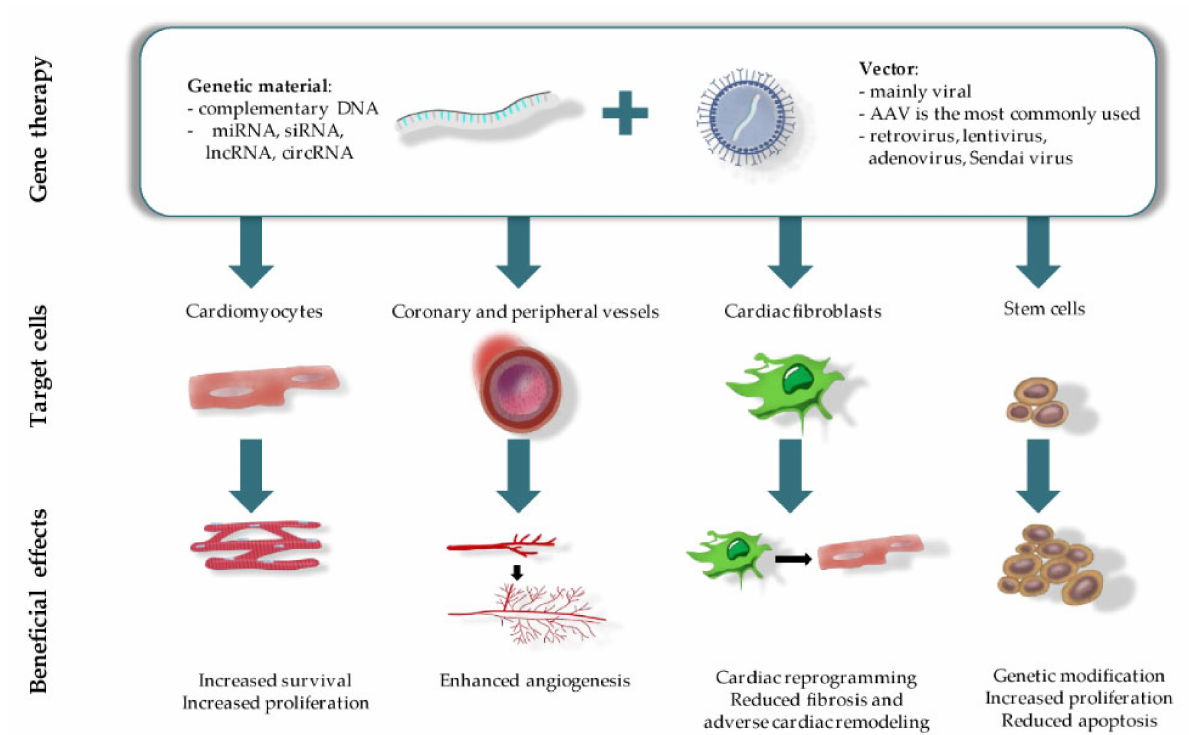
Figure 1. Gene therapy and therapeutic outcomes in CVDs